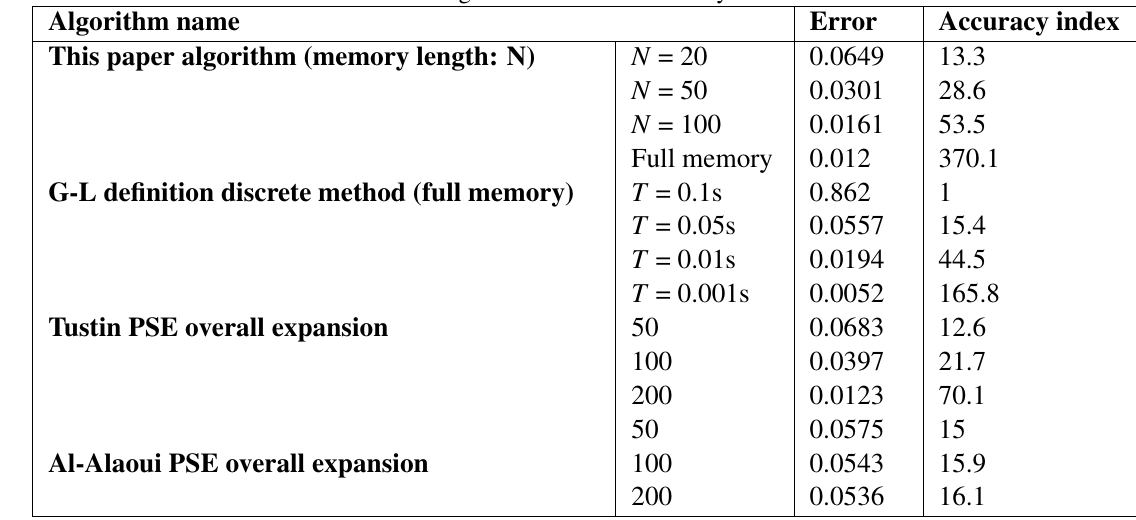
Table 1 Algorithm error and accuracy